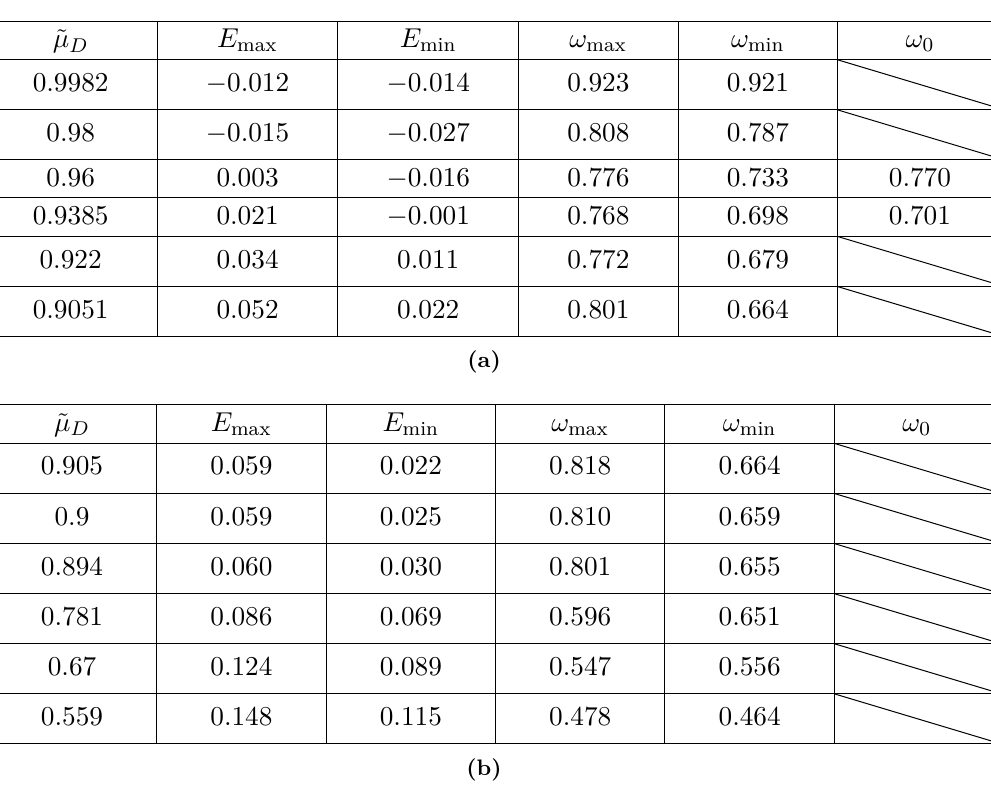
For one-branch (top panel) and multi-branch (bottom panel) solution families, the maximum value E max and the minimum value E min of the binding energy E B of the DBSs, the synchronized frequency ˜ ω corresponding to E max and E min ( ω max and ω min ). ω 0 is the value of the synchronized frequency ˜ ω when E B = 0